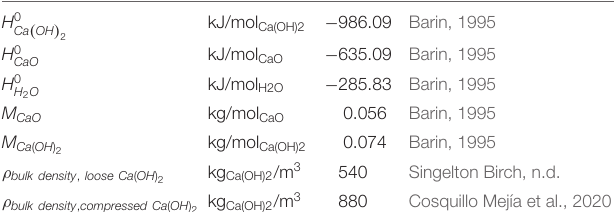
TABLE 1 | Characteristic values of the reaction